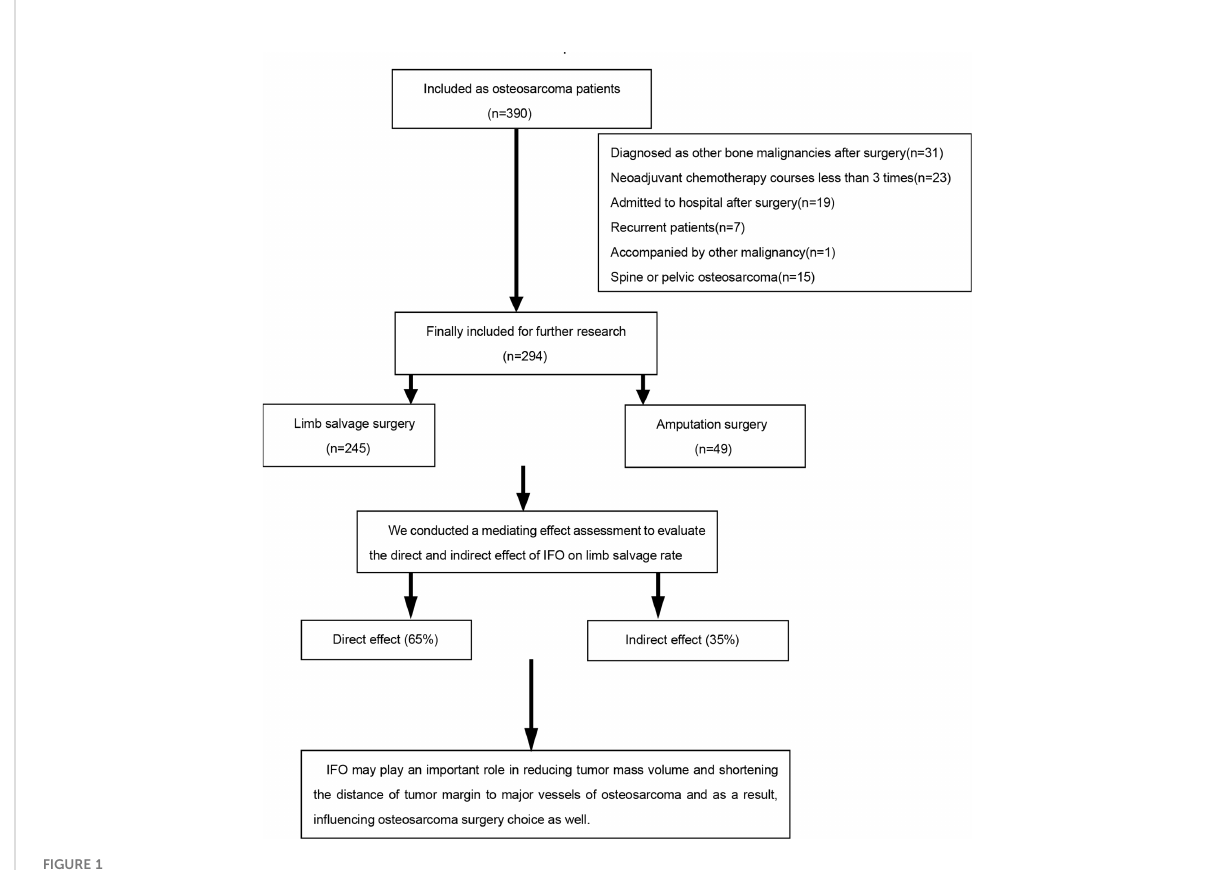
FIGURE 1 Patient Screening